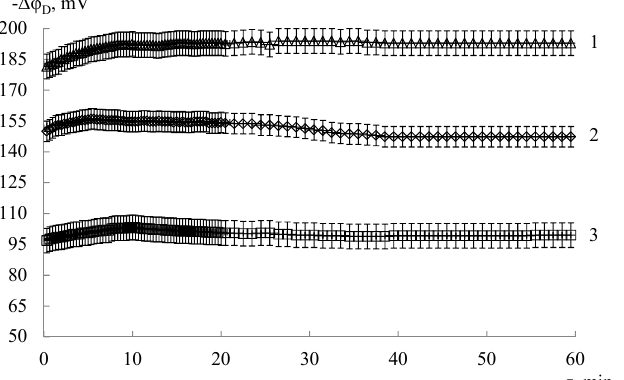
Figure 3. The dependence of response time of DP-sensor based on Nafion membrane in test solutions ( c (Asp) = c (KOH), M): 1—1.0 × 10 − 4 ; 2—1.0 × 10 − 3 ; 3—1.0 × 10 − 2